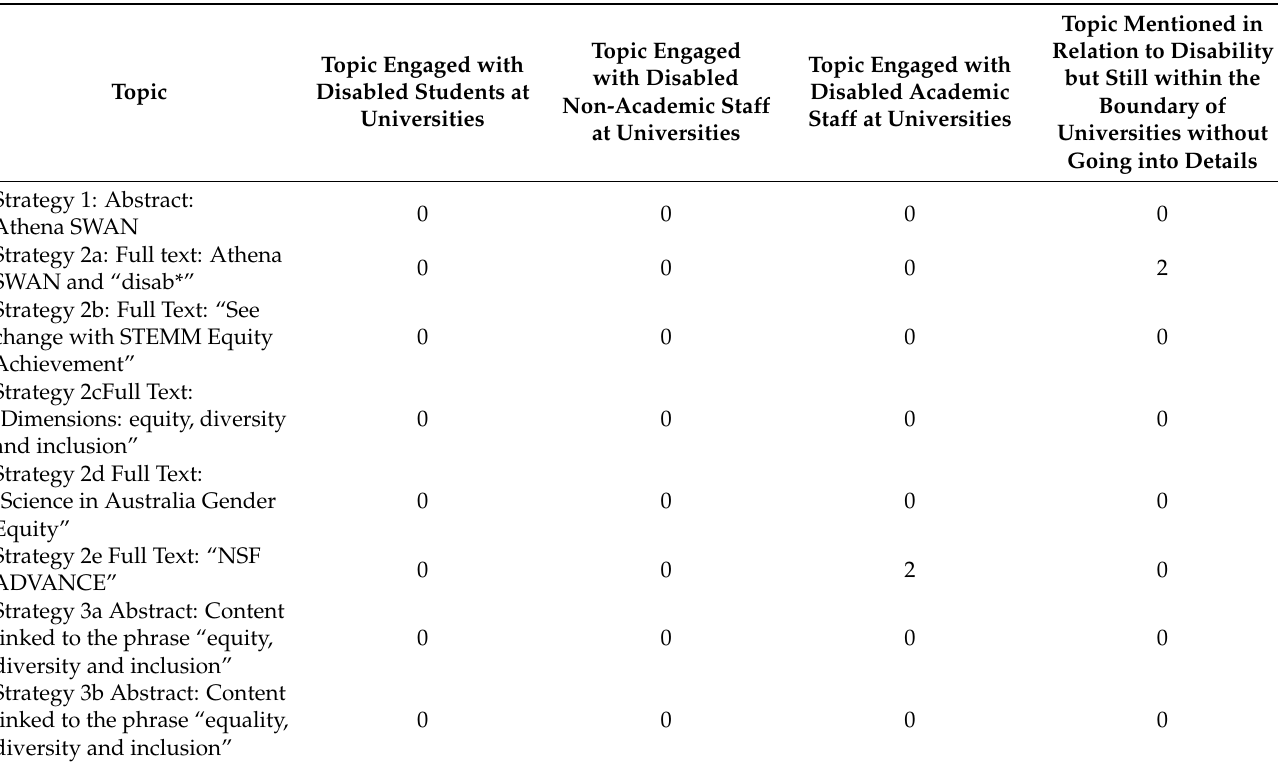
Topic Mentioned in but Still within